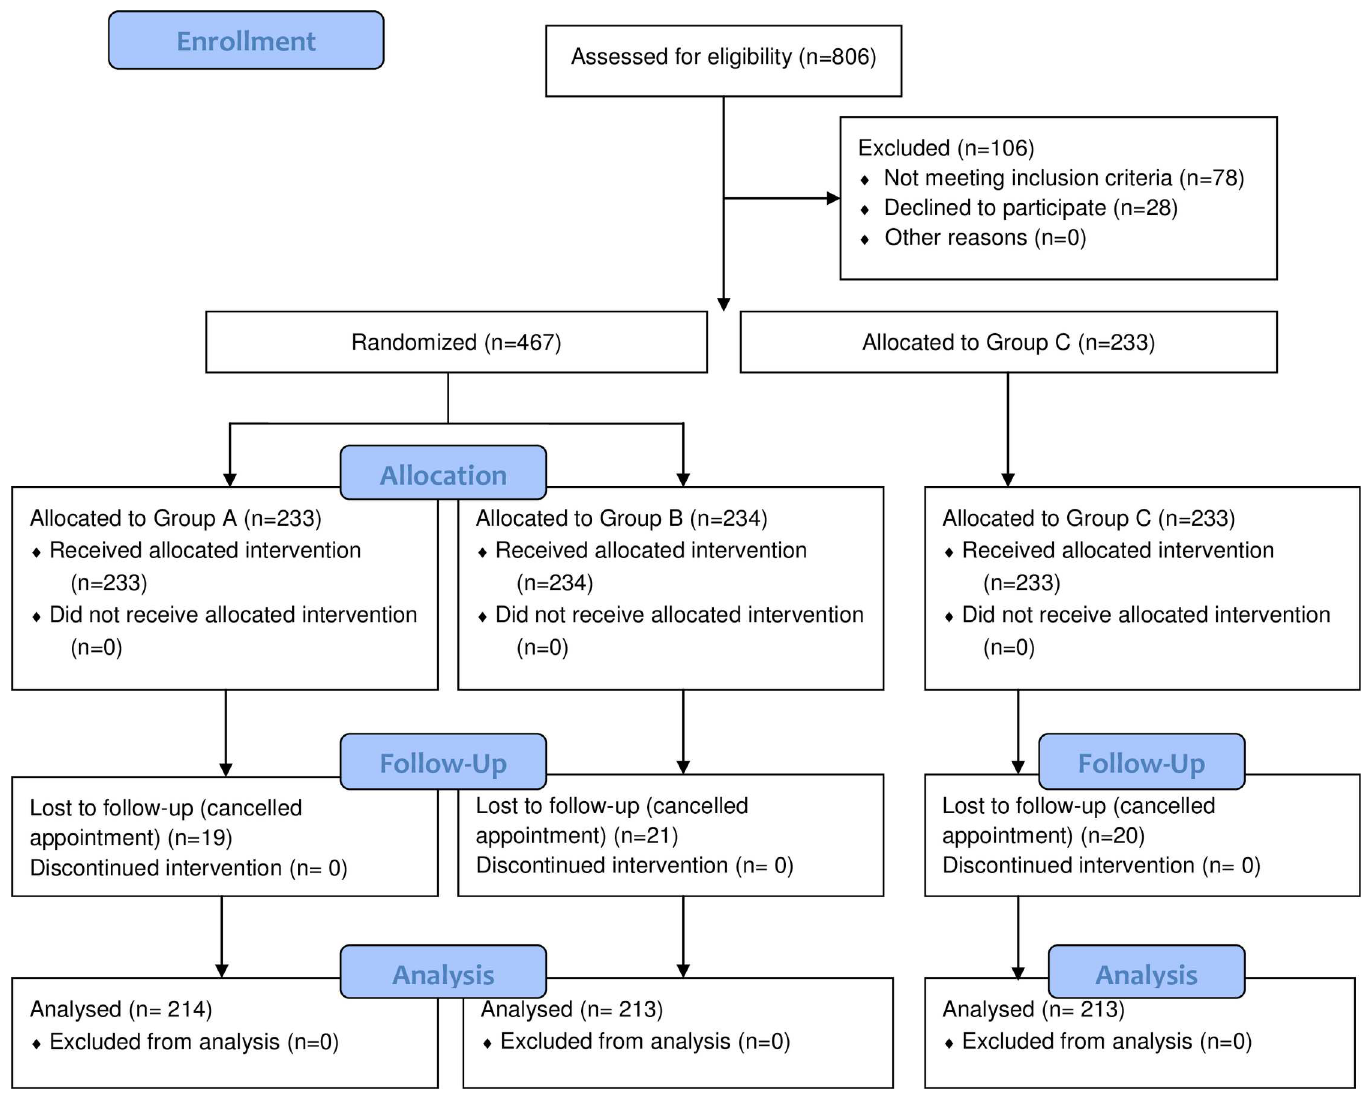
Fig 1. Flowchart of the study. PP,